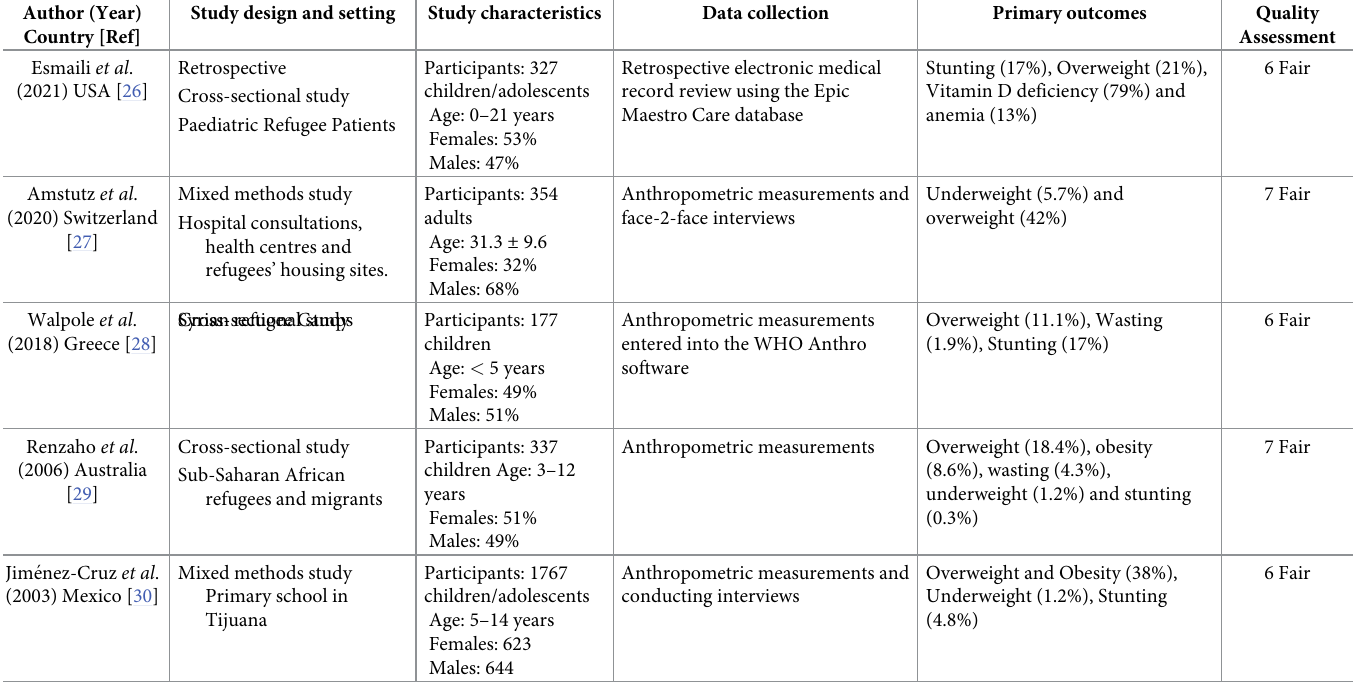
Table 1. Summary of selected